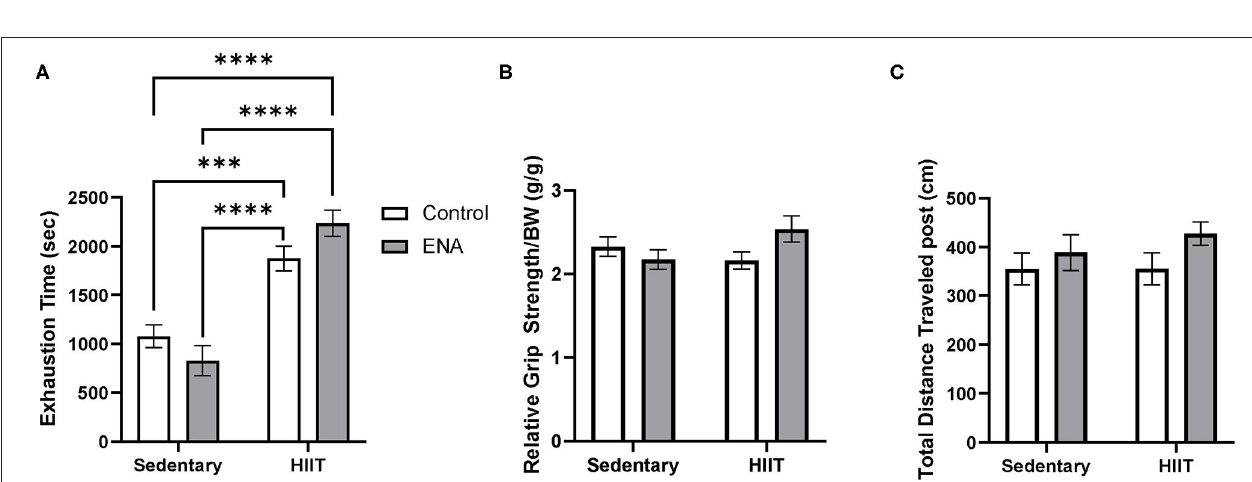
FIGURE 3 | The body weight changes. (A) The time course of mean body weight changes during intervention and the timeline for training sessions and tests. (B) Body weight changes after the intervention. Con, control; Sed, sedentary; Ex, exercise; ENA, Enalapril. * p < 0.05.